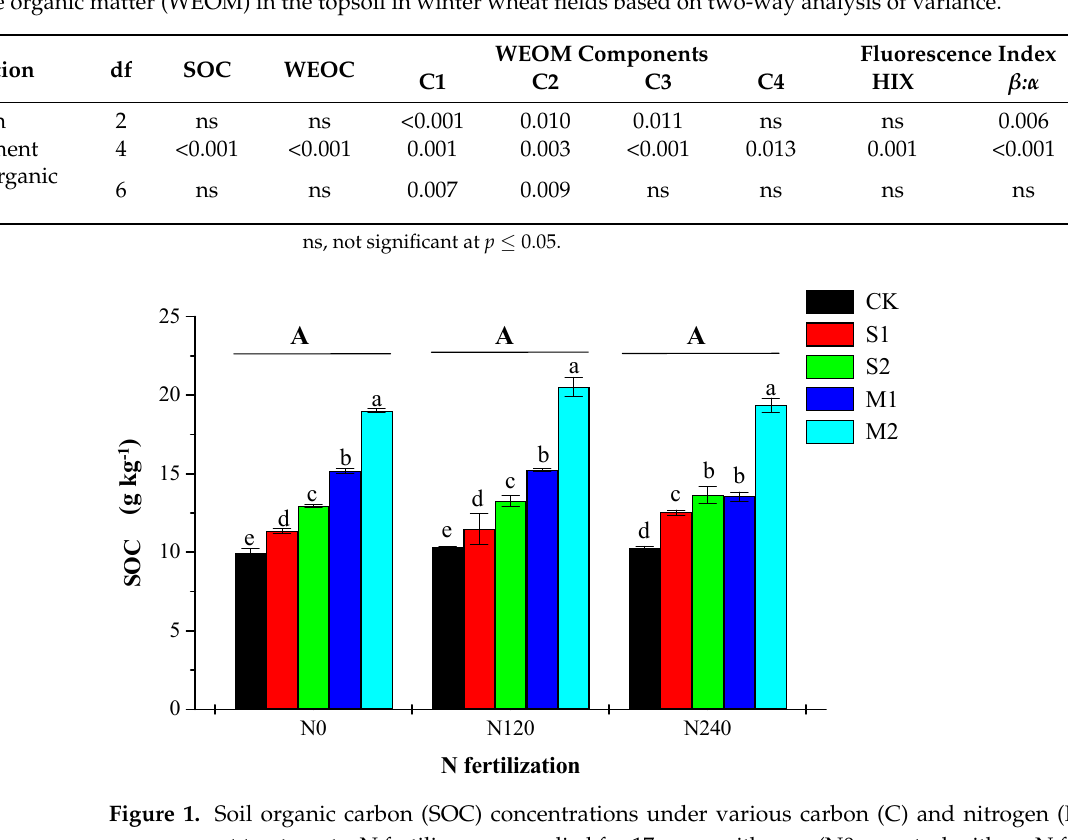
Table 2. The effects of nitrogen (N) fertilization and organic amendment practices on soil organic carbon (SOC) and water-extractable organic matter (WEOM) in the topsoil in winter wheat fields based on two-way analysis of variance.